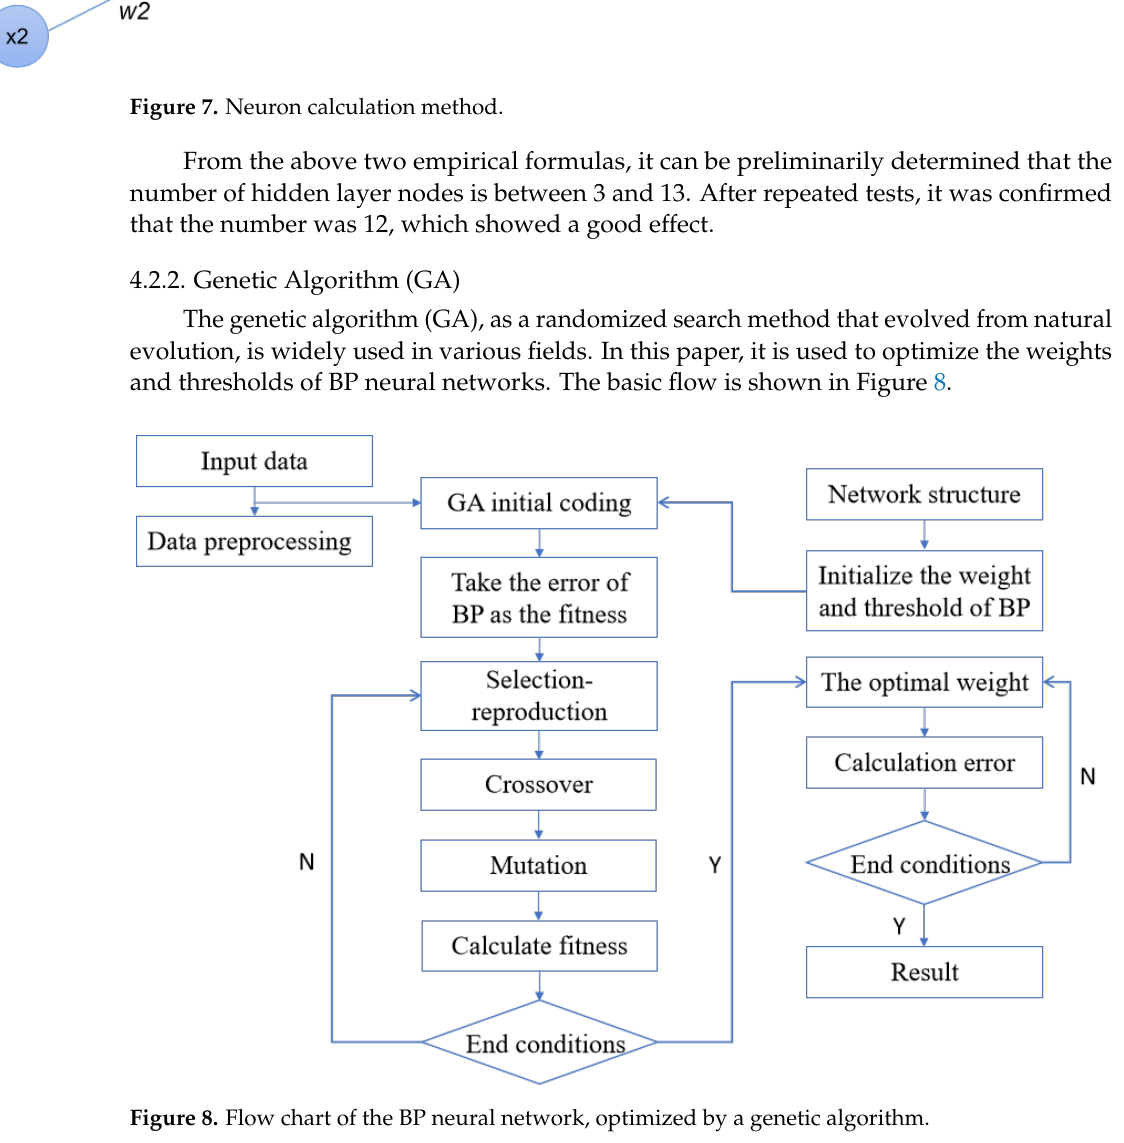
Figure 8. Flow chart of the BP neural network, optimized by a genetic algorithm. (1) Population